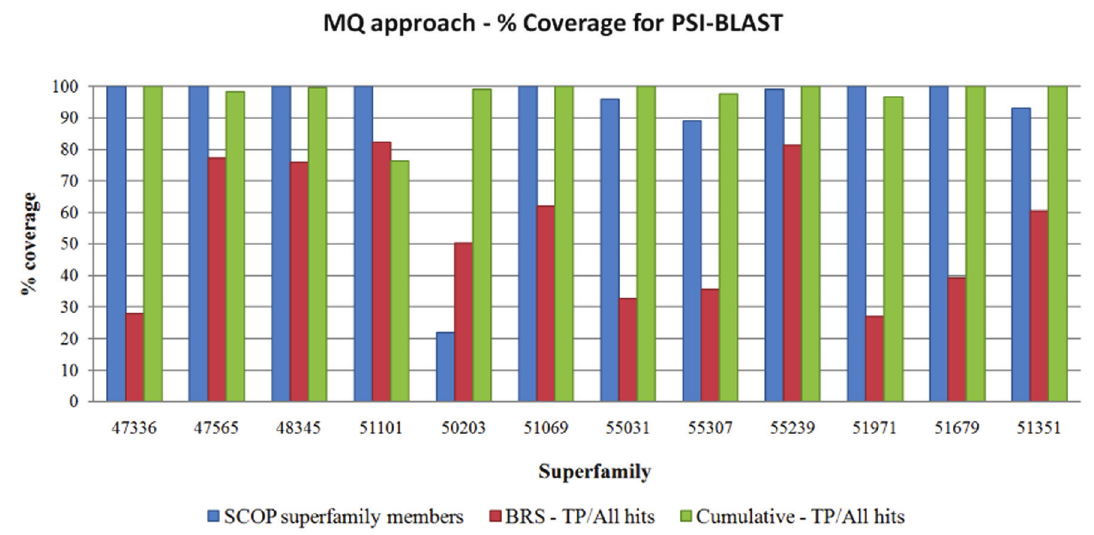
Figure 3. Coverage of 12 superfamilies for the PSI-BLAST sequence search. The blue bars correspond to the percentage of SCOP members identified as hits. The red bars correspond to percentage ratio of TP (True Positives) identified by BRS (Best Representative Sequence) and All Hits (BRS-TP/All Hits). The green bars correspond to percentage ratio of Cumulative TP identified for a superfamily and All Hits (Cum-TP/All